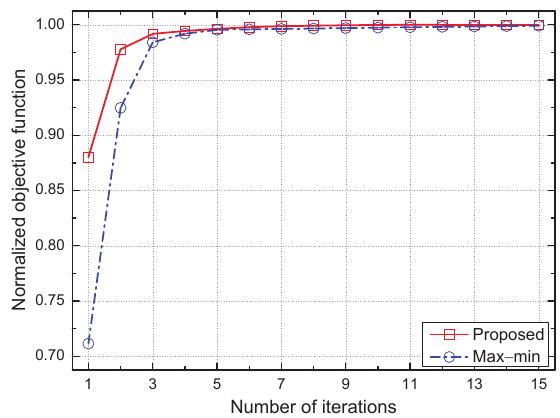
Figure 2. Convergence of the proposed